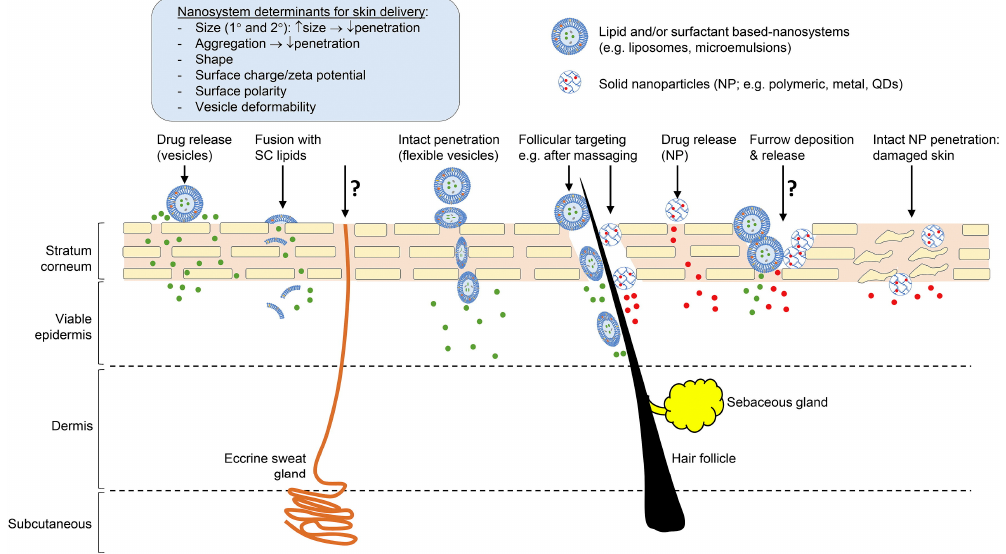
Figure 1. Properties of nanosystems determining skin absorption and potential routes of penetration (skin layer thicknesses not drawn to scale). Reproduced with permission from [5].